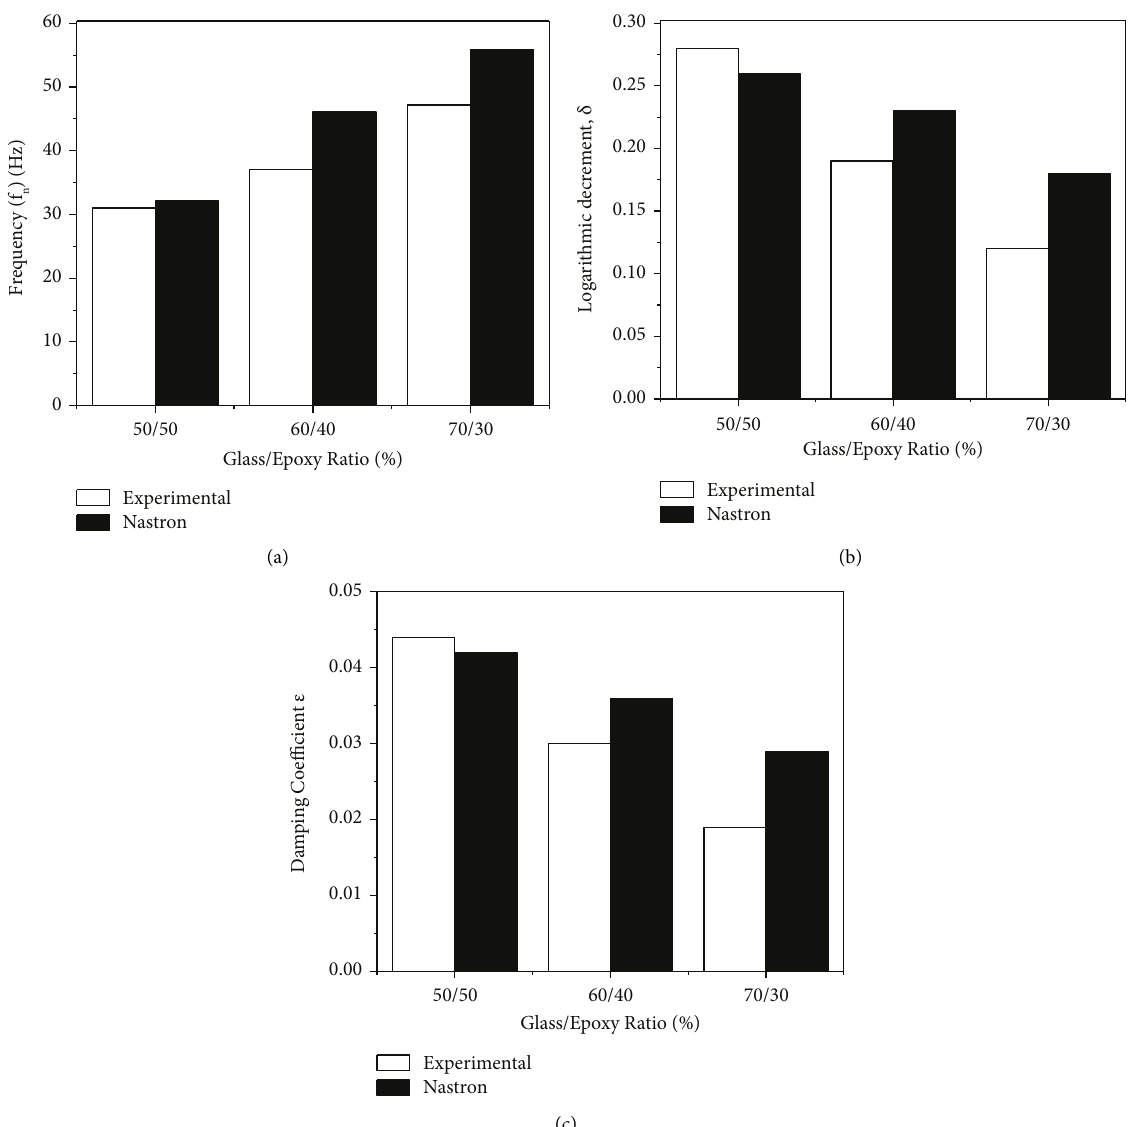
Figure 15: Comparison between the experimental and analytical values of (a) frequency, (b) logarithmic decrement, and (c) damping coefficient for mode 1. Table 5: Comparison of experimental and analytical frequency values of 50/50, 60/40, and 70/30% composites. Experimental and analytical frequency values of the